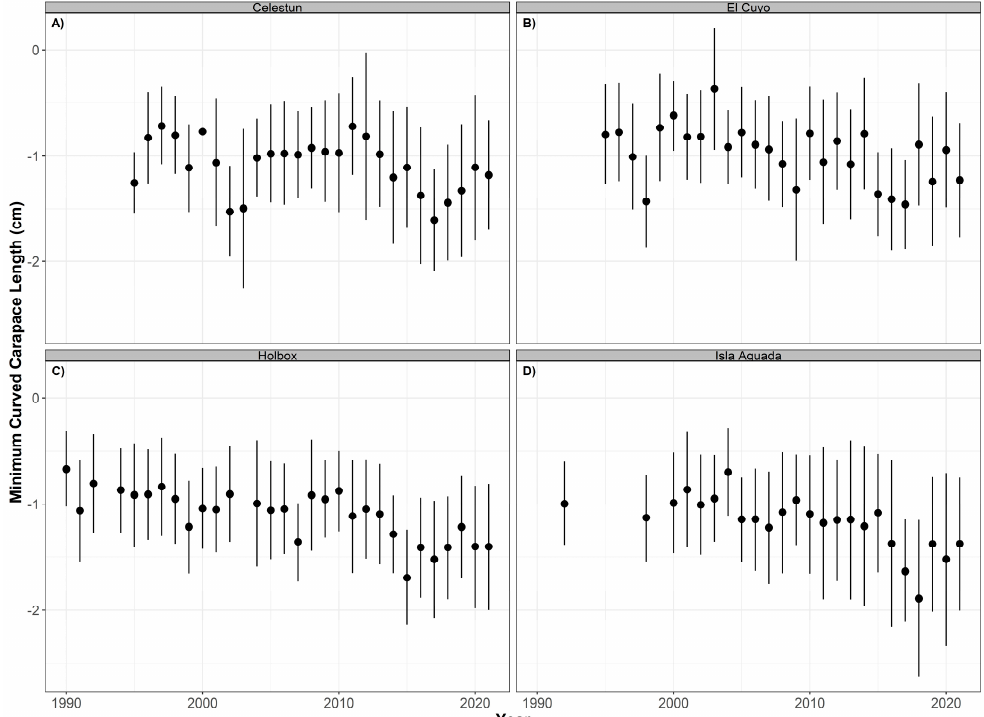
Figure 4. Time series of minimum curved carapace length (annual mean ± SD) for hawksbill turtles ( Eretmochelys imbricata ) nesting at Celestún ( A ), El Cuyo ( B ), Holbox ( C ), and Isla Aguada ( D ) from 1990 to 2021.